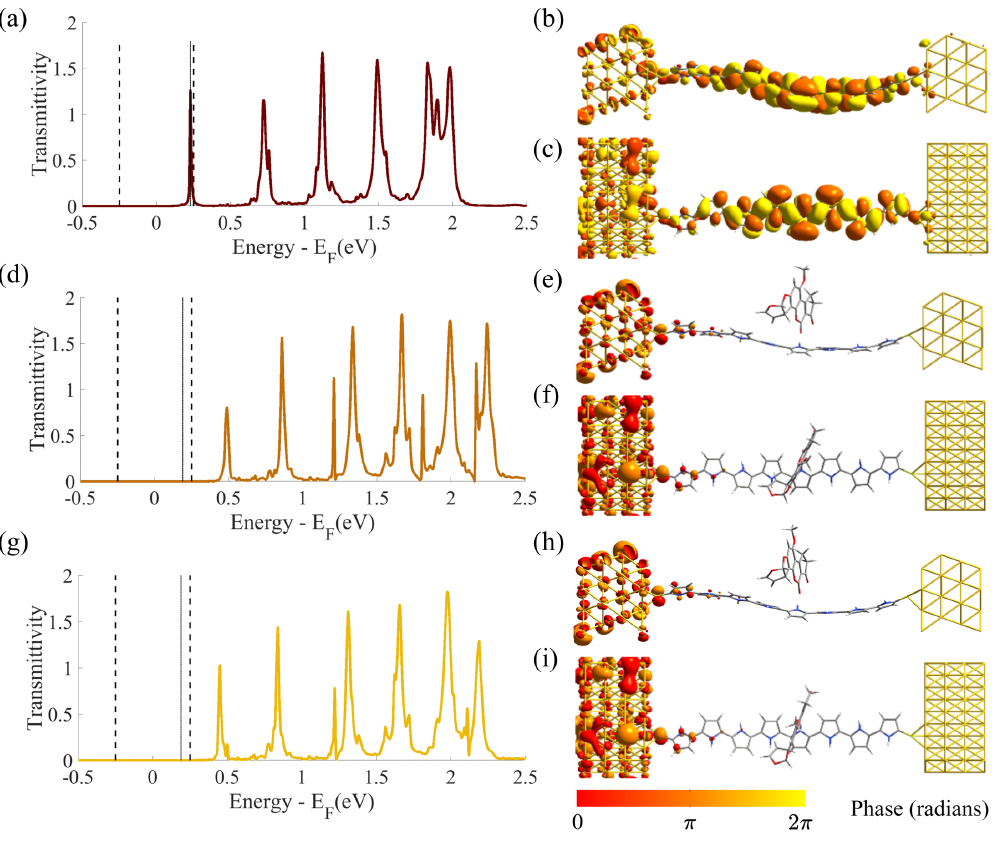
Figure 10. Computed transmission spectra TS ( E ) of the Au-8PyDT FET sensor for V GS = 4.75 V and V DS = 0.5 V without ( a ) and with the AFB1 target, with an x -rotation of 25 ◦ ( d ) and 45 ◦ ( g ). The dashed black lines represent the BW . The solid black lines show the energy values of the transmission peak included within the BW with the highest transmittivity (the transmission peaks in the cases with AFB1 are not visible on the linear scale). For these energy values (0.23 eV, 0.19 eV and 0.19 eV, respectively), the transmission eigenstates, TE s, with the highest transmission coefficient, TC , were computed and shown with the same isovalue (0.25) without AFB1 in front ( b ) and top ( c ) views (TC = 0.74), with AFB1 and x -rotation of 25 ◦ in front ( e ) and top ( f ) views (TC = 0.0004) and with AFB1 and x -rotation of 45 ◦ in front ( h ) and top ( i ) views (TC =